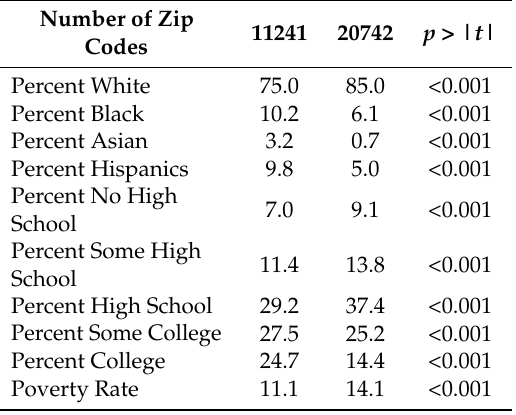
Table 3. Comparison between policyholders’ zip codes with other zip codes.